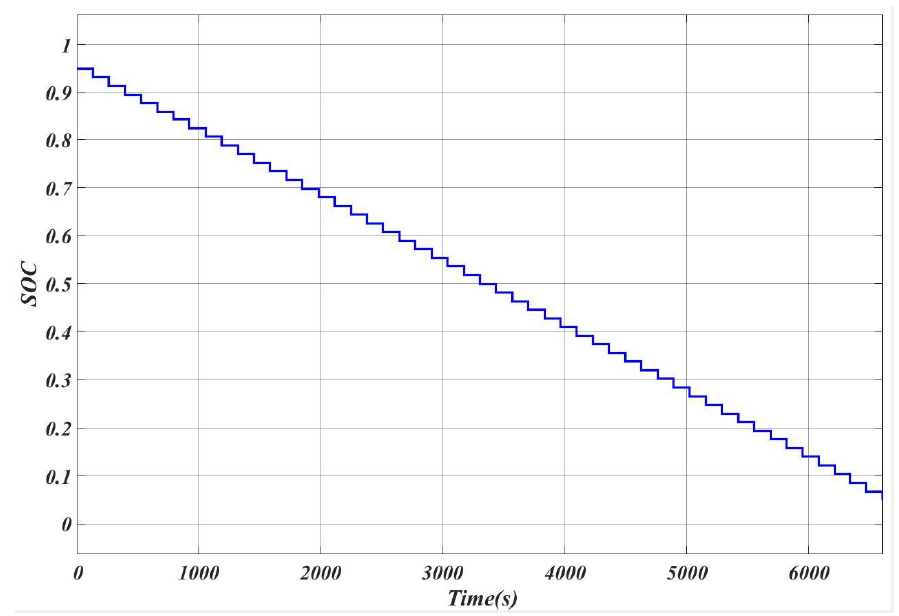
Figure 10. SOC vs. Time for pulse discharge.